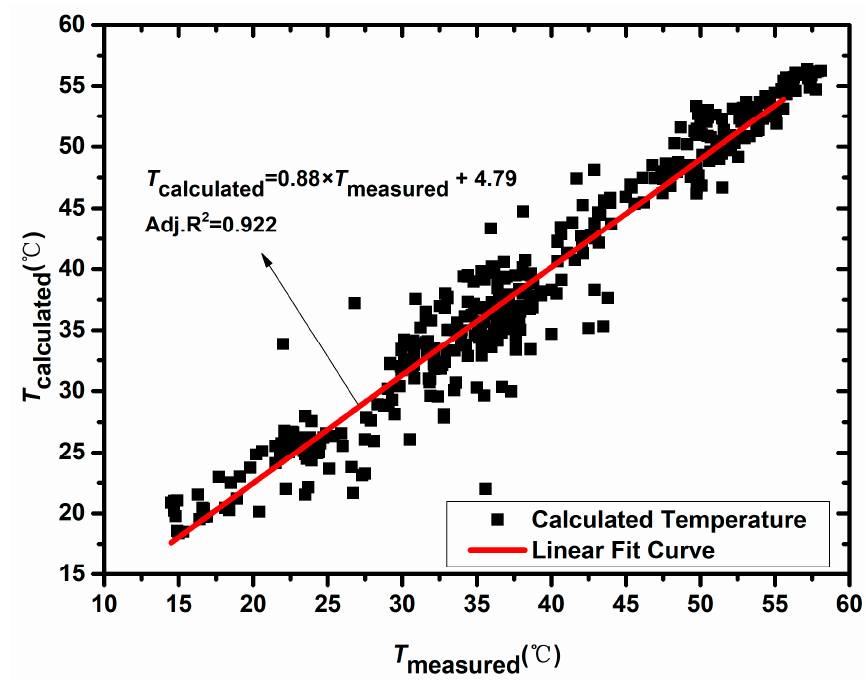
Figure 9. Calculated module temperature as a linear function of the measured module temperature.